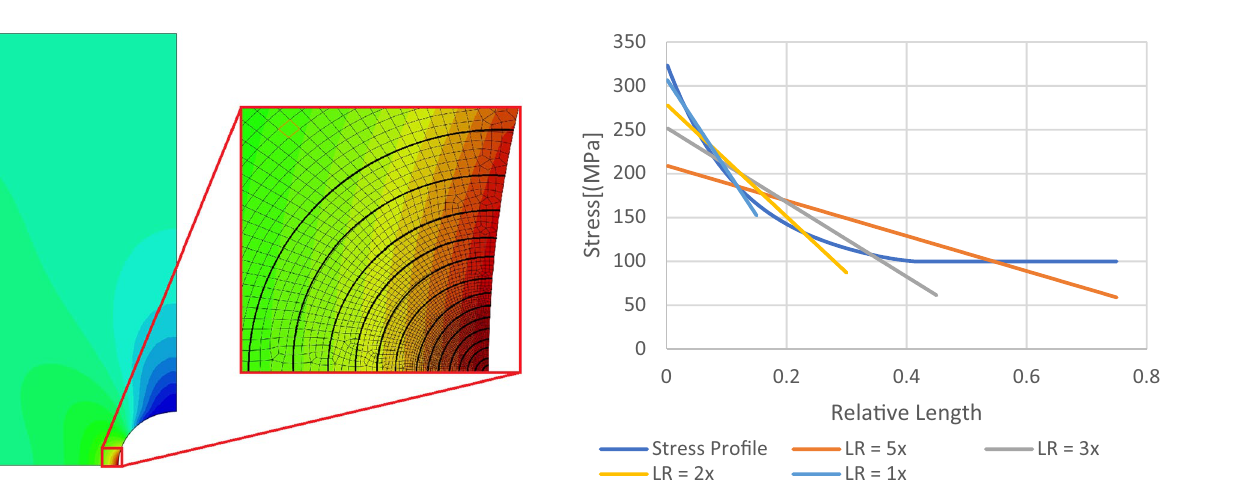
Fig. 8 1D average stress profile and linearized curves for plate with hole diameter 0.25 the plate width